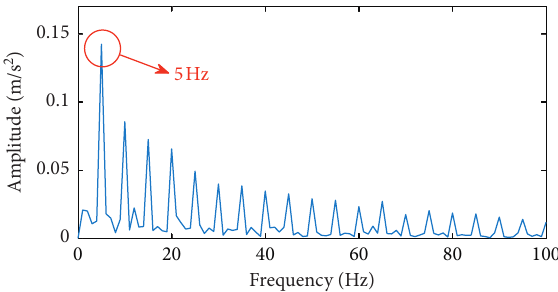
Figure 5: The envelope spectrum for the reconstructed signal. free signal. In the table, P n represents the noise intensity, SNR represents the signal-to-noise ratio, t i represents the impulse response time identified by this method, and CC